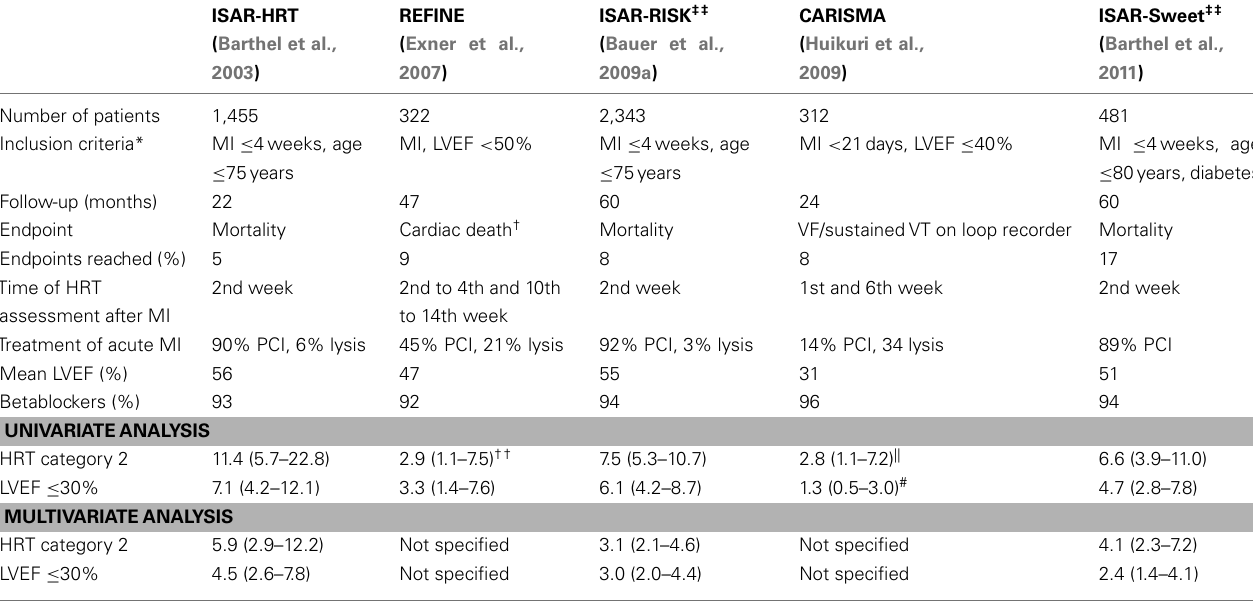
Table 2 | Prospective studies (or sub-studies) investigating heart rate turbulence as a post-infarction